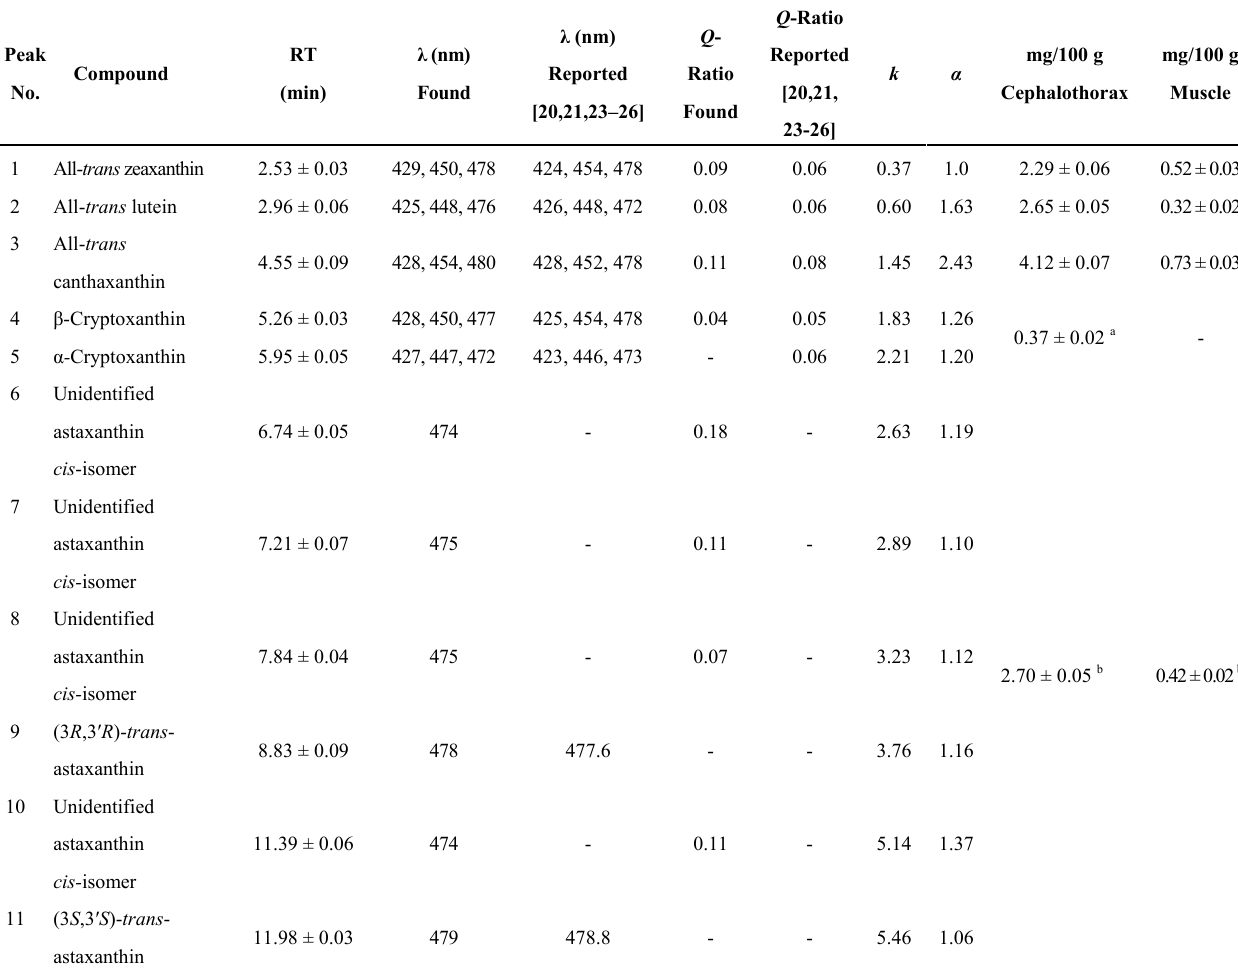
Table 3. Chromatographic identification and quantification data of carotenoids from Penaeus kerathurus